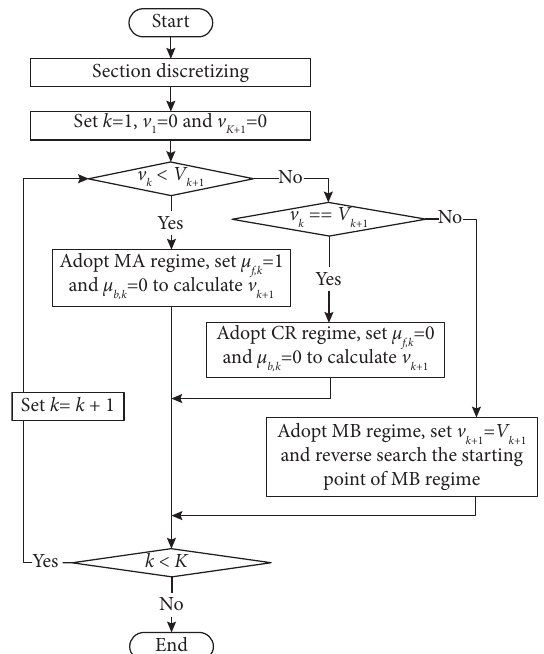
Figure 4: Te illustration of the fat-out trajectory calculation